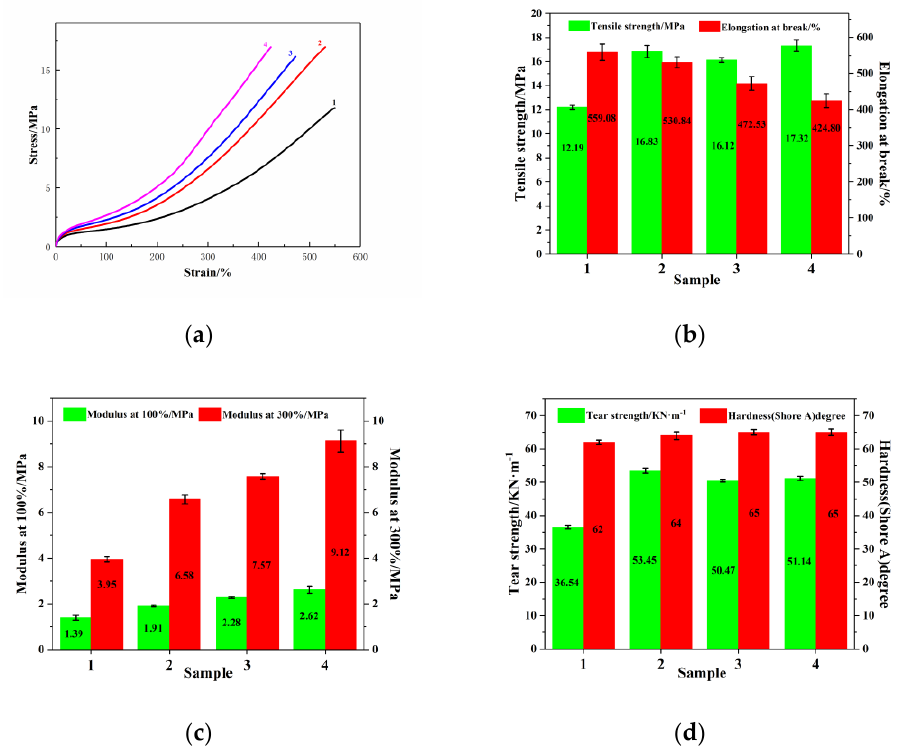
Figure 9. ( a ) The stress − strain curves of rubber composites. ( b – d ) The mechanical properties of the rubber composites. (1) SiO 2 /EUG/SBR, (2) MEST − SiO 2 /EUG/SBR, (3) SiO 2 /EEUG/EUG/SBR, (4) MTES − SiO 2 /EEUG/EUG/SBR. (4) MTES-SiO 2 /EEUG/EUG/SBR.